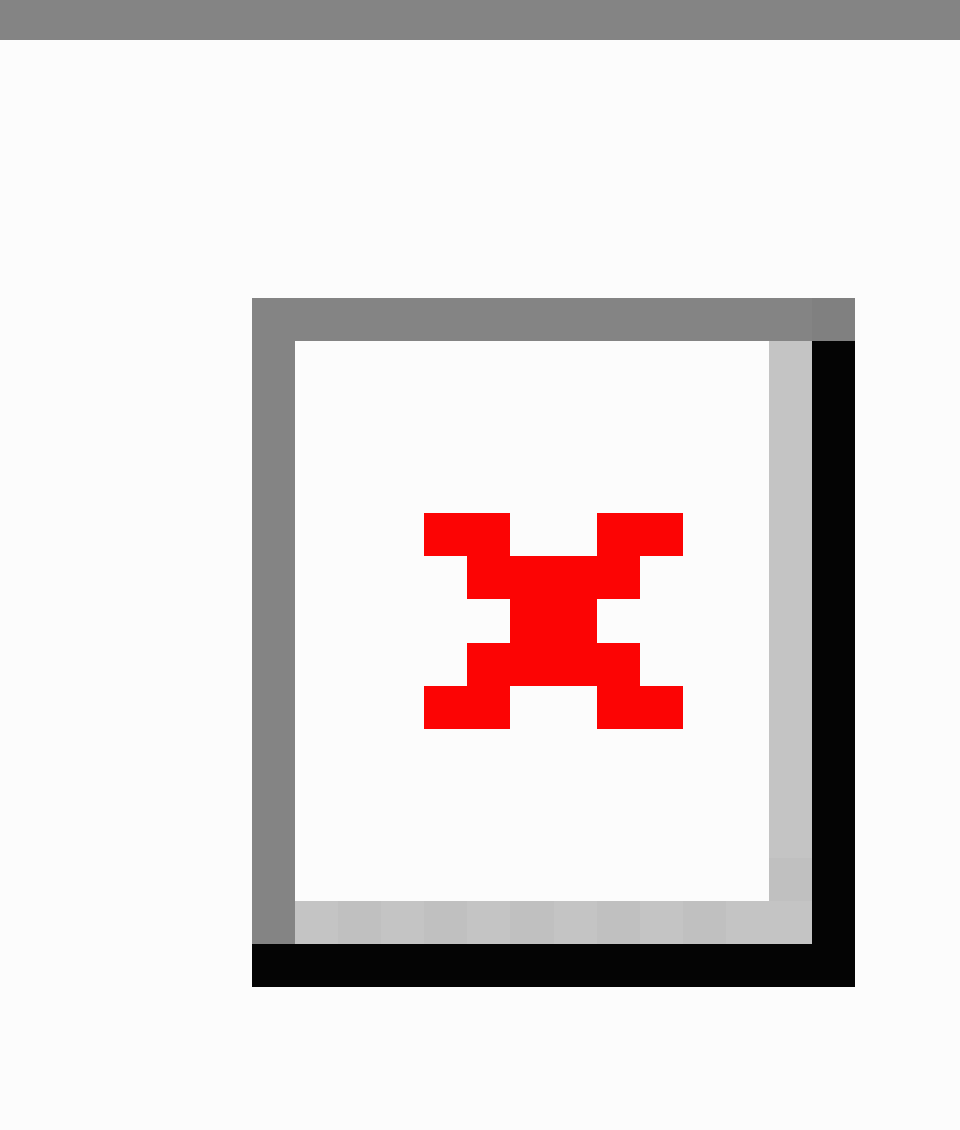
Figure 2. Summary of themes that emerged from the data and which participant perspectives they